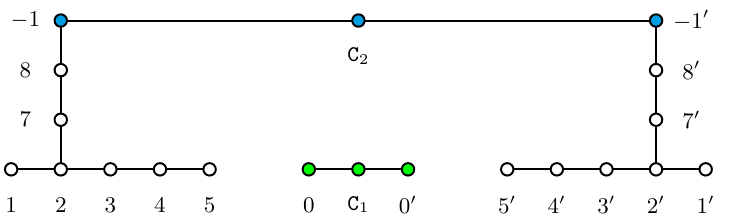
w 6 (cid:2) 1 w 0 , 6 2 2